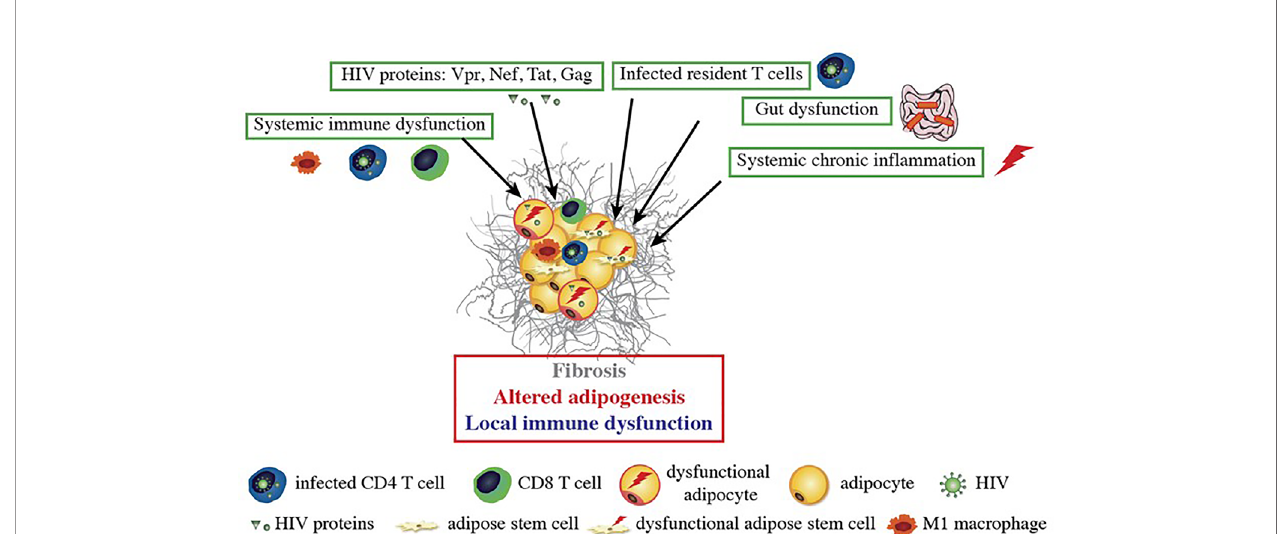
FIGURE 1 | HIV-related alterations in AT. HIV itself and the viral proteins produced by infected cells induce fi brosis and alter adipogenesis and local immune functions. HIV proteins are secreted by infected cells within AT and can impact the nearby adipose stem cells (ASCs) and adipocytes. Dysfunctional ASCs present mitochondrial dysfunction, elevated levels of oxidative stress and a pro fi brotic phenotype. The proteins impede the ASCs ’ ability to differentiate into adipocytes; this leads to dysfunctional adipocytes with low expression of adipogenic markers, lipid accumulation, and leptin and adiponectin secretion. HIV-protein-treated adipocytes also acquired a pro-in fl ammatory phenotype that is involved in local in fl ammation and immune dysfunction. Systemic factors (gut dysfunction, systemic chronic in fl ammation, and immune dysfunction) also contribute to AT dysfunction, with the induction of CD8 T cells, macrophages in fi ltration, and a shift towards a pro-in fl ammatory M1 macrophage pro fi